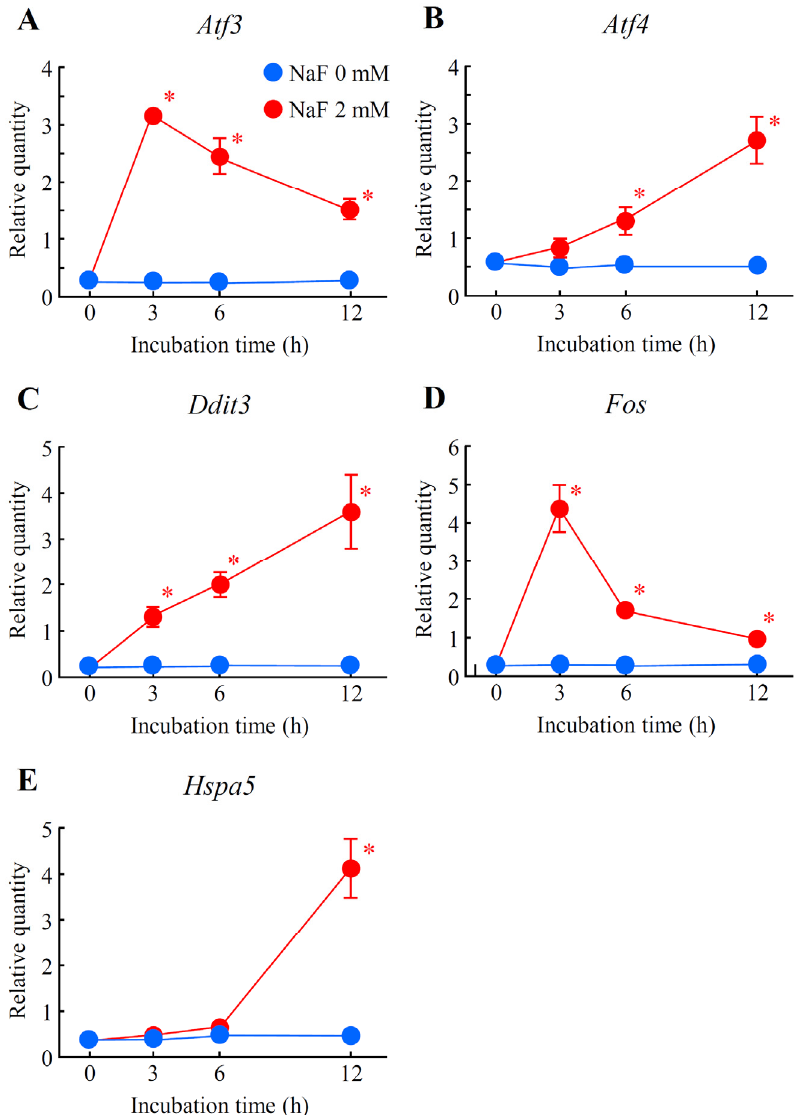
Figure 8. Verification of microarray results with real-time quantitative polymerase chain reaction (qPCR). Cells were incubated with or without NaF (2 mM) for 0 to 12 h. Real-time qPCR was performed. ( A ) Atf3 ; ( B ) Atf4 ; ( C ) Ddit3 ; ( D ) Fos ; and ( E ) Hspa5 . The data represent means ± standard deviations from 4 different experiments. Each expression level was normalized by Gapdh. Open circles, 0 mM NaF; closed circles, 2 mM NaF. * p < 0.05 vs. each NaF (0 mM) (Student’s t